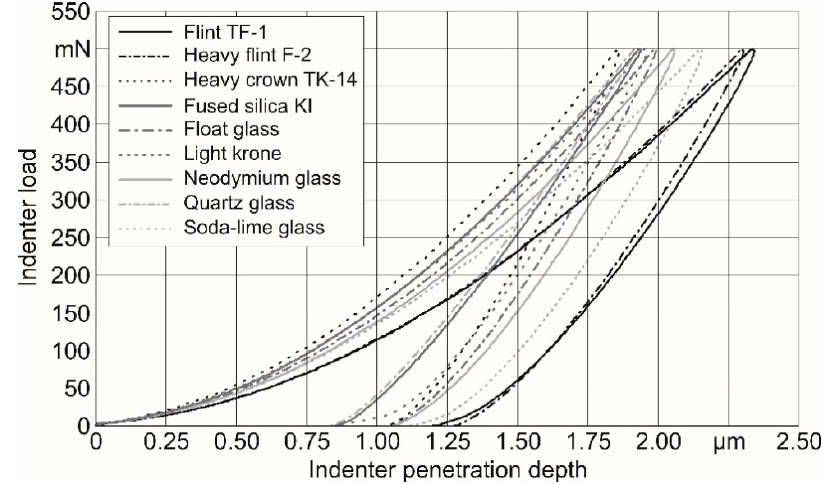
Figure 3. Diagrams of the indentation into the studied glasses surface.